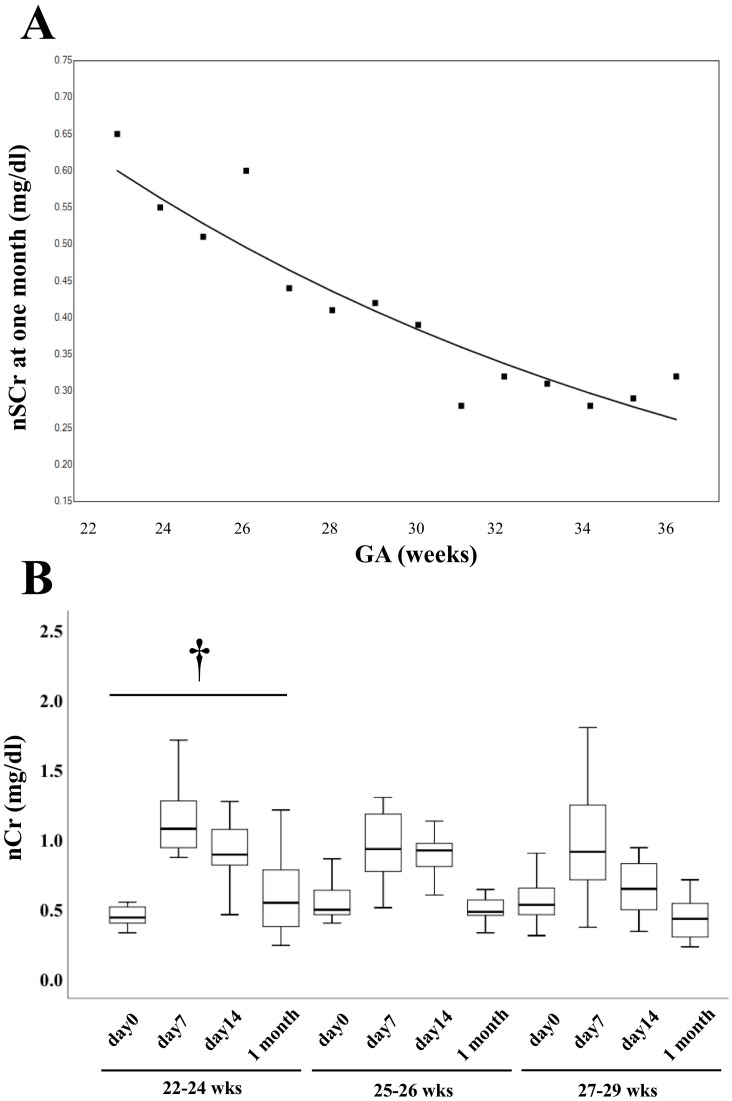
Creatinine levels during early postnatal period.A. nSCr of preterm infants born at <29 weeks’ gestational age from birth until four weeks of life. B. Serum and plasma creatinine levels in three groups of preterm infants born at gestationsal age of <29 weeks’ at one month are presented as box (interquartile range) and whisker (5%–95% range) plots. Creatinine at day 7 was plasma creatinine. †P<0.05.